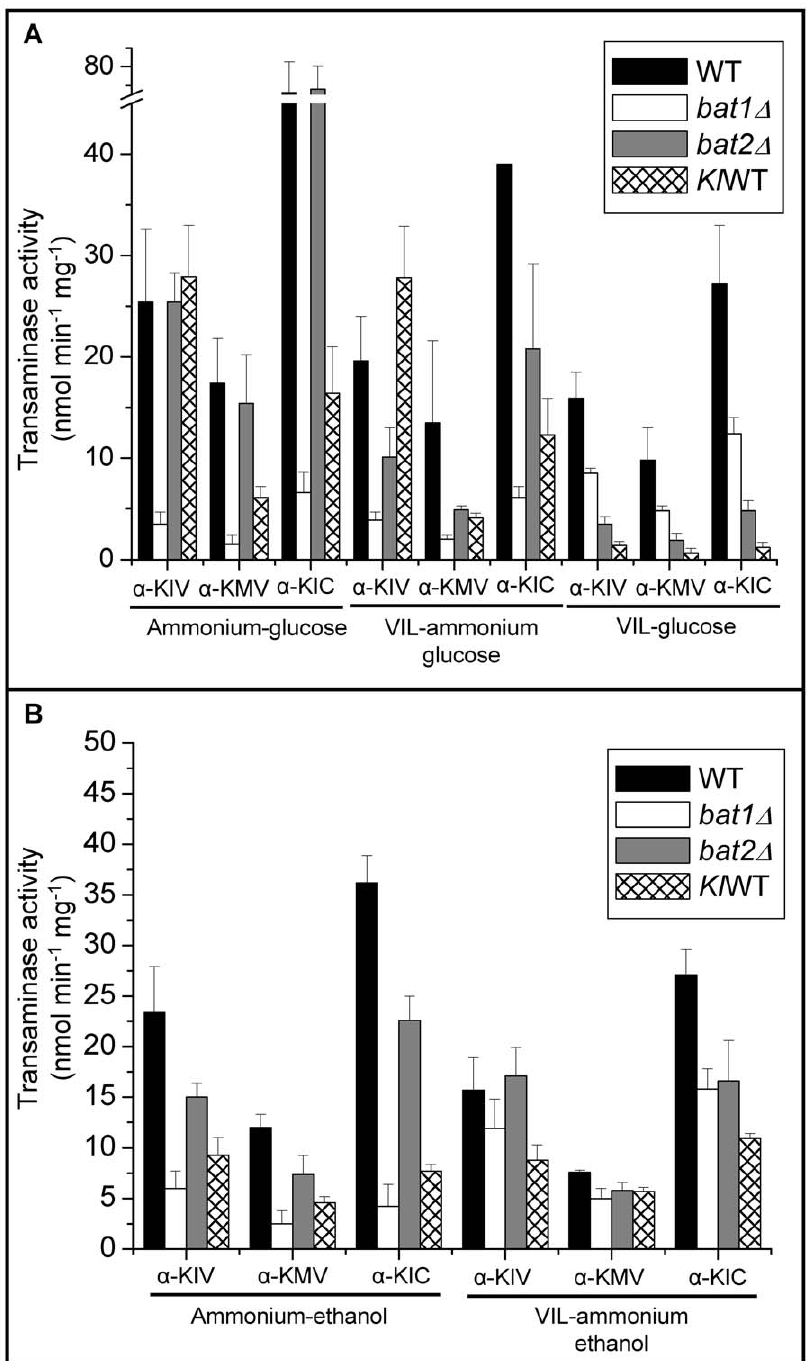
Figure 5. Branched chain aminotransferase activity. S. cerevisiae wild type, bat1 D , bat2 D and K. lactis wt ( Kl WT) strains were grown on glucose (A) or ethanol (B) as carbon source and ammonium or VIL as nitrogen sources. Aminotransferase activity was determined in cell free extracts as indicated in Materials and methods using a -ketoisovalerate ( a -KIV), a -ketoisocaproate ( a -KIC) or a -ketomethylvalerate ( a -KMV) as substrates. Transaminase activity is reported as nmol mg/l min 2 1 . Values are presented as mean from at least three measurements 6 S.